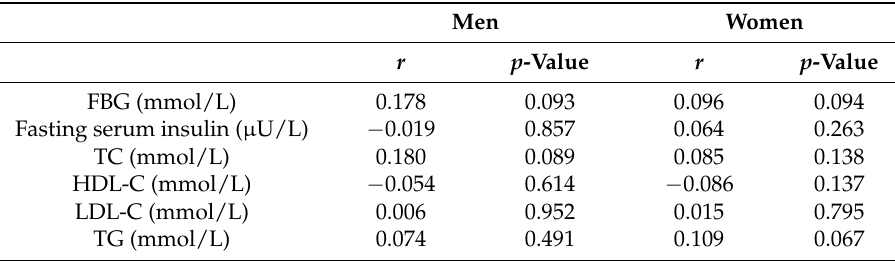
Table 4. Partial correlation coefficients between glycolipid metabolism and REE.